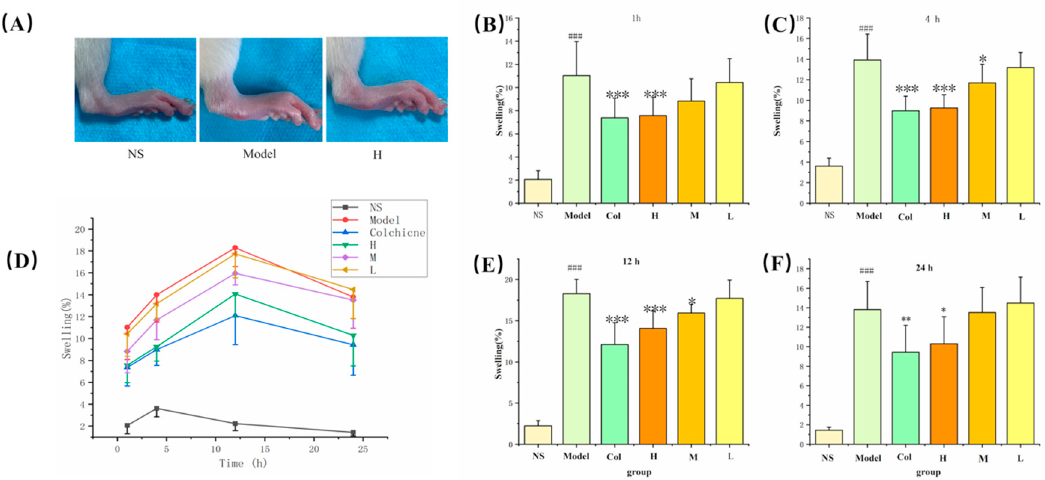
Figure 6. Representative images of joints from NS, Model, and H groups at 12 h ( A ). Effects of PLR-CDs on the swelling degree of rats’ joints after molding for 24 h ( D ). NS and Model represent normal control group and model group, respectively; Col, H, M, and L were treated with colchicine and high, medium, and low doses, respectively, of PLR-CDs. The swelling degree was measured and calculated at 1 h ( B ), 4 h ( C ), 12 h ( E ), and 24 h ( F ).